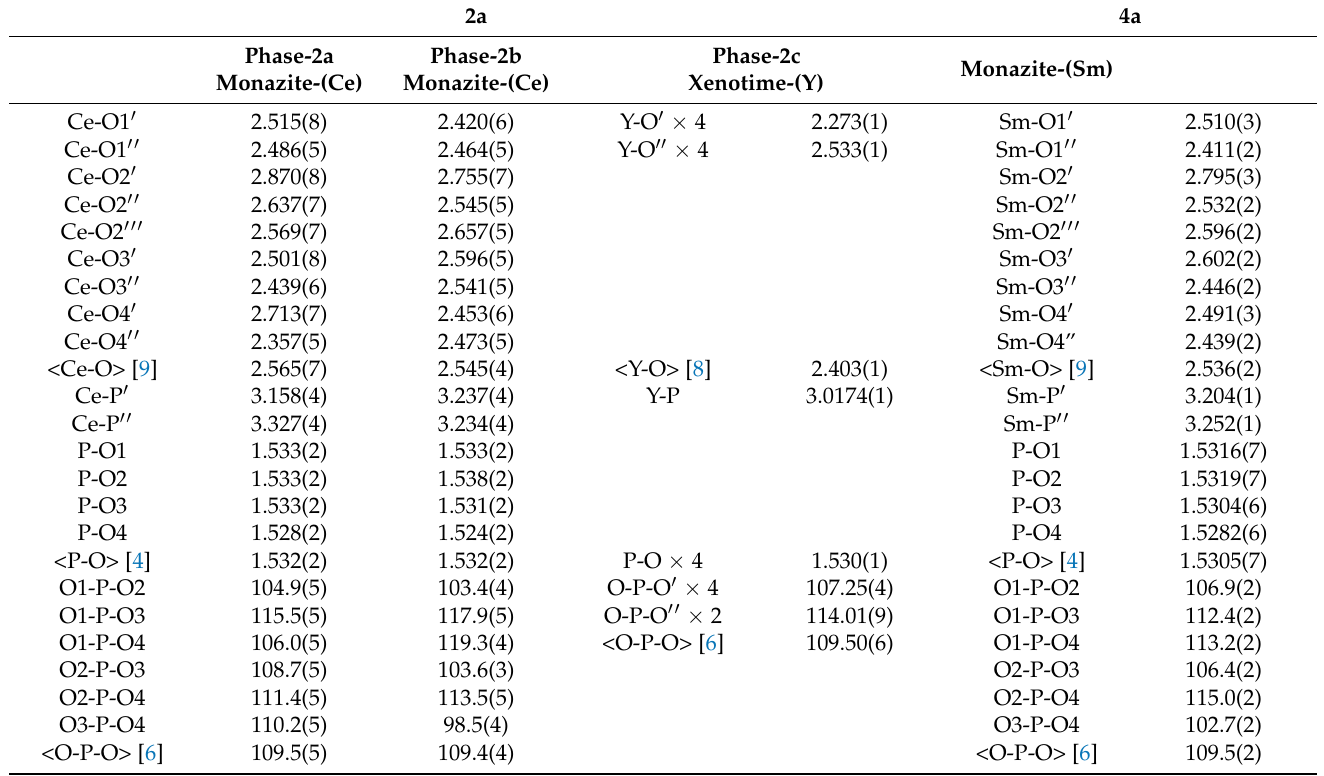
Table 8. Bond distances * (Å) and angles ( ◦ ) for samples 2a and